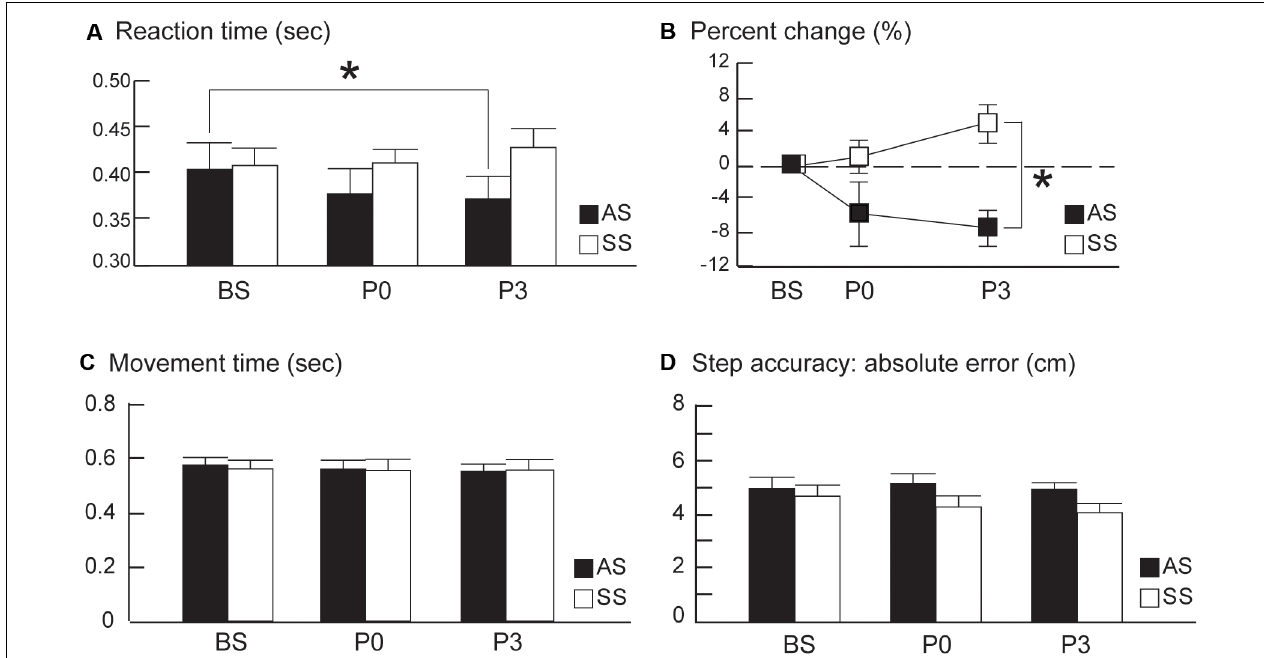
FIGURE 2 | (A) Average stepping reaction times (RTs). (B) Average percent changes from the baseline RTs, (C) average movement time, and (D) average step accuracy from pre- to post-tDCS in the anodal and sham tDCS groups (AS and SS, respectively) before (baseline, BS) and 0 and 30 min after tDCS (P0 and P3, respectively). The averages of the last 20 trials at BS were compared to the averages of 20 trials at P0 and P3 between the two groups. Error bars, ± 1 SEM. Asterisks (*) indicate significant post hoc differences between